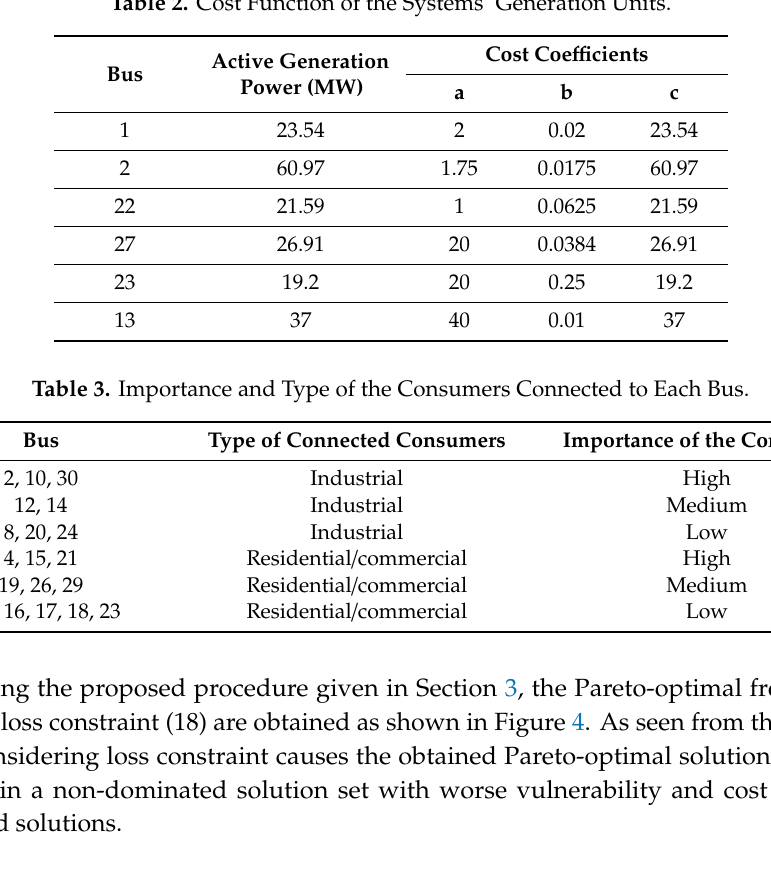
Table 2. Cost Function of the Systems’ Generation Units.